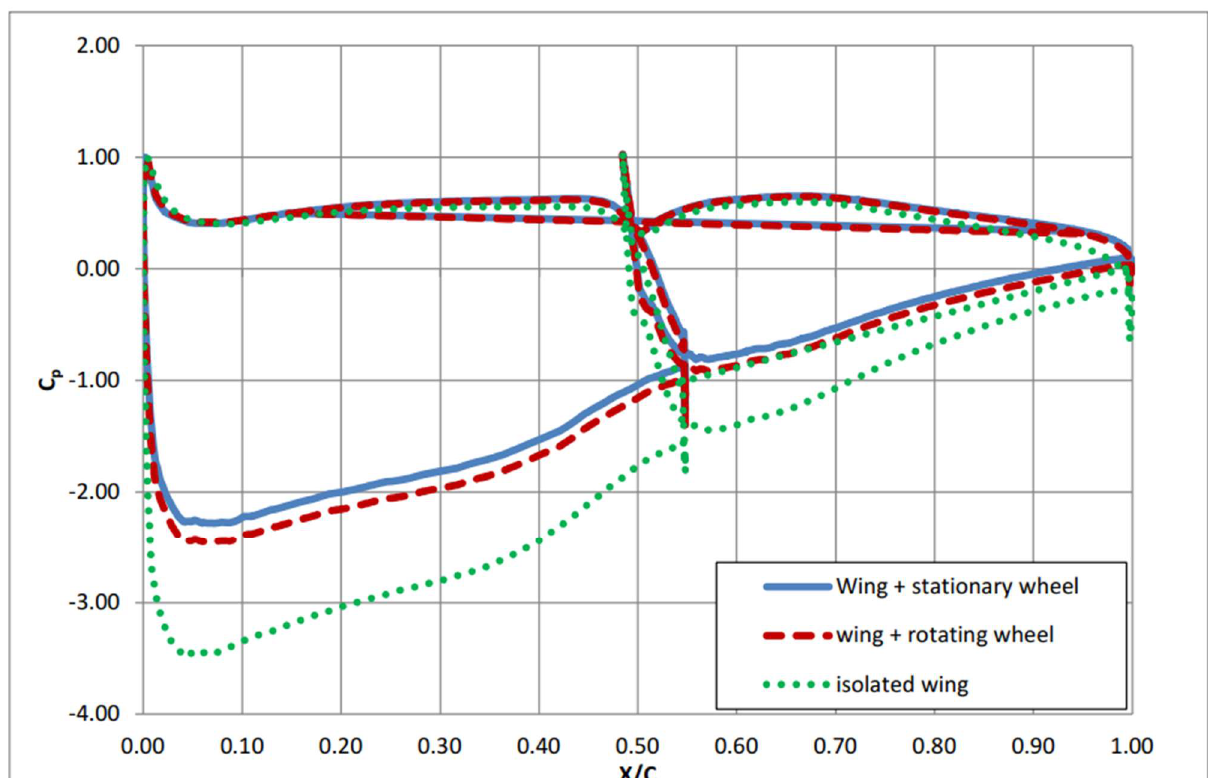
Figure 14. Pressure coefficient distributions on main airfoil and flap - section at y = −0.48 m.